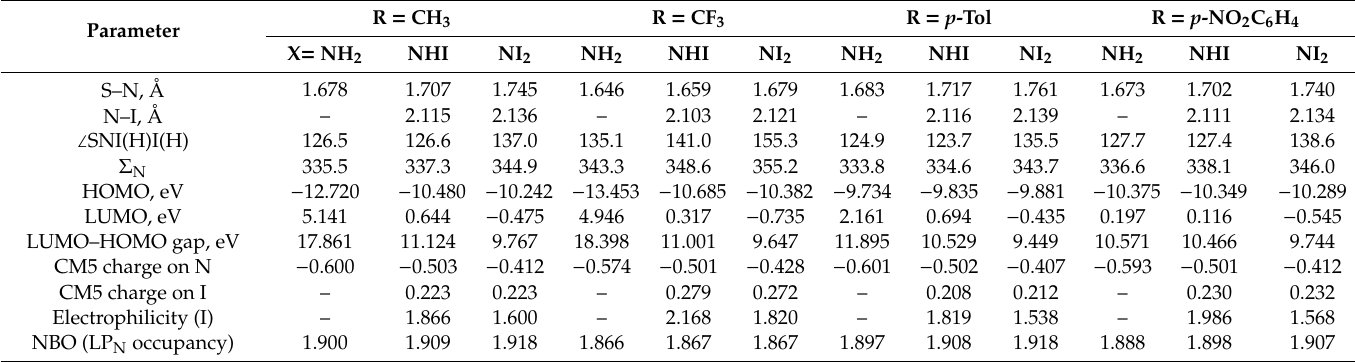
Table 3. Geometric and electronic parameters of sulfonamides, mono- and diiodosulfonamides RSO 2 X, X = NH 2–n I n (MP2 / DGDZVP // B3LYP / D GDZVP). HOMO (highest occupied molecular orbital), LUMO (lowest unoccupied molecular orbital), CM5 (charge model 5), NBO (natural bond order), LP (lone